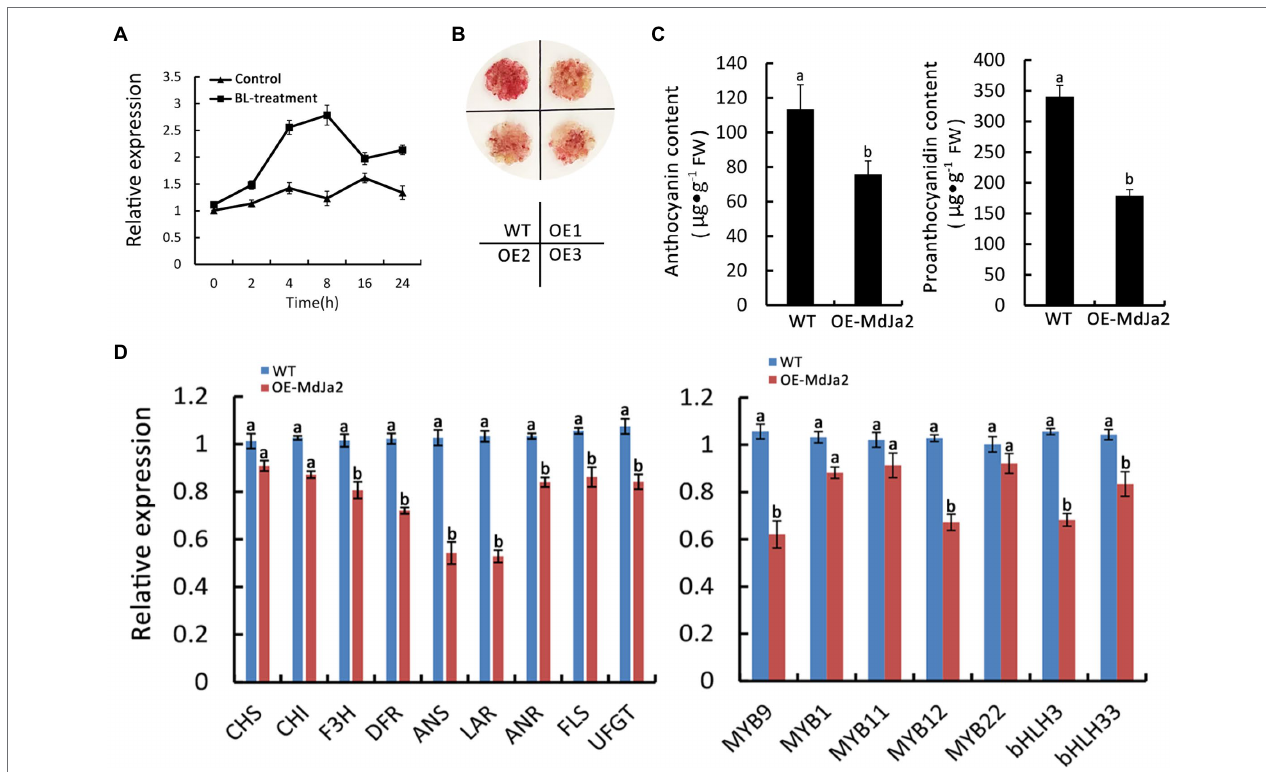
FIGURE 2 | MdJa2 responds to the BR signal and negatively regulates the synthesis of anthocyanin and proanthocyanidin in red-fleshed apple calli. (A) The expression of MdJa2 in red-fleshed apple seedlings treated with BL as determined by qRT-PCR. (B) Phenotypes of OE-MdJa2 red-fleshed apple calli. (C) Anthocyanin and proanthocyanidin contents in wild-type (WT) and transgenic lines. (D) Expressions of the genes related to flavonoid synthesis in OE-MdJa2 red-fleshed apple calli as determined by qRT-PCR. Statistical significance is indicated by different lowercase letters ( p < 0.05